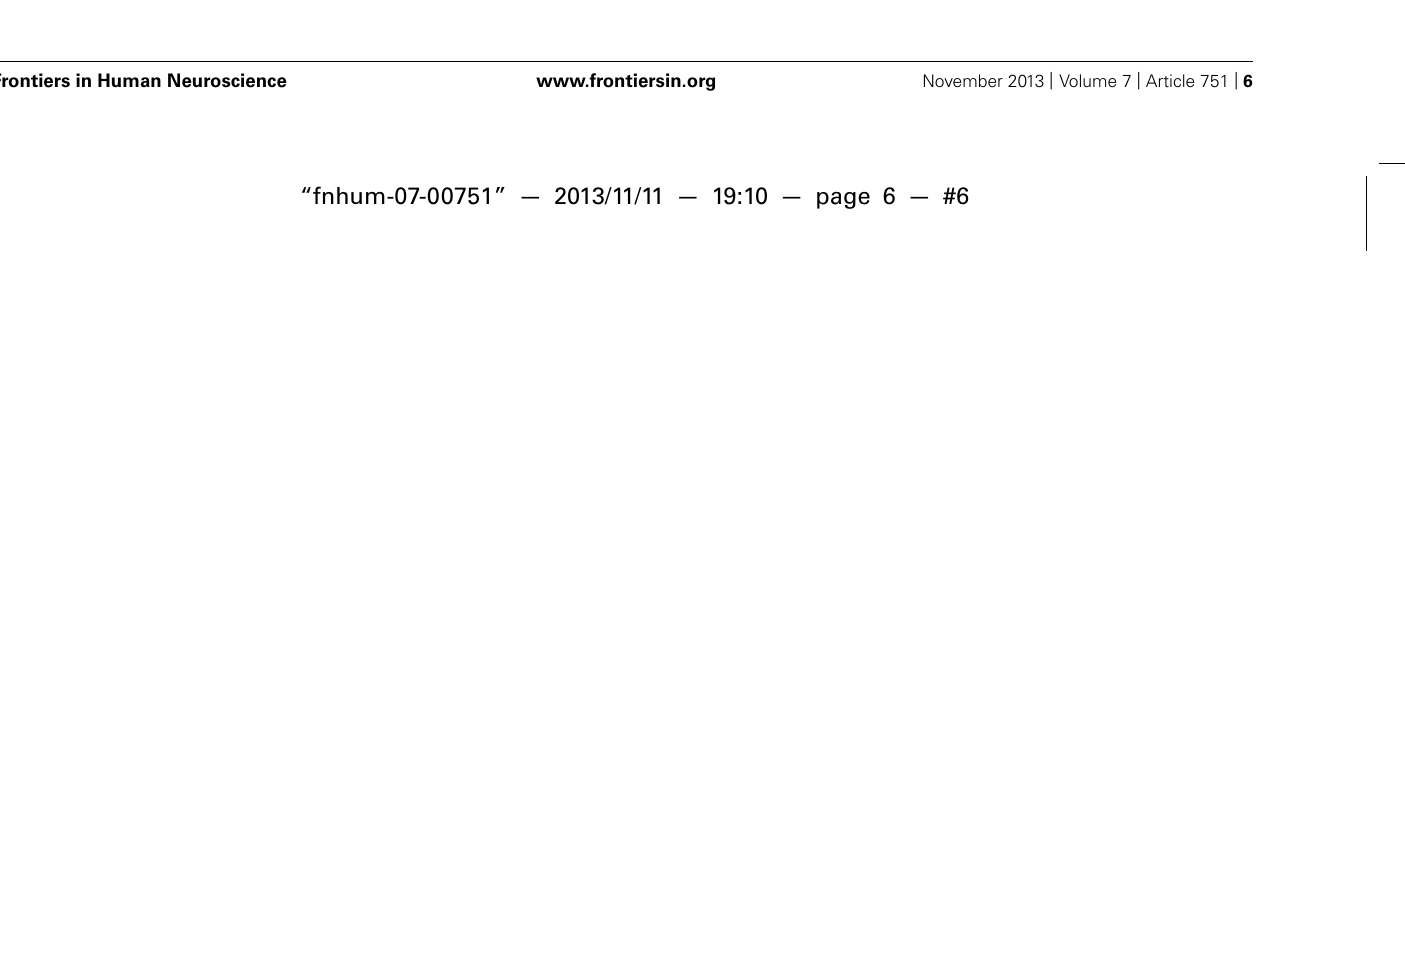
represent target time for the go task, and the vertical thick lines represent stop-signal onset.Time scales relative to target are displayed at the bottom. (B) Scalp topographies of averaged EEGs in the go and stop( − 200) trials for six participants in a contralateral-TMS session (left 2 × 4 arrays) and for six participants in an ipsilateral-TMS session (right 2 × 4 arrays).The topographies are displayed only at − 200, 0, 100, and 200 ms relative to